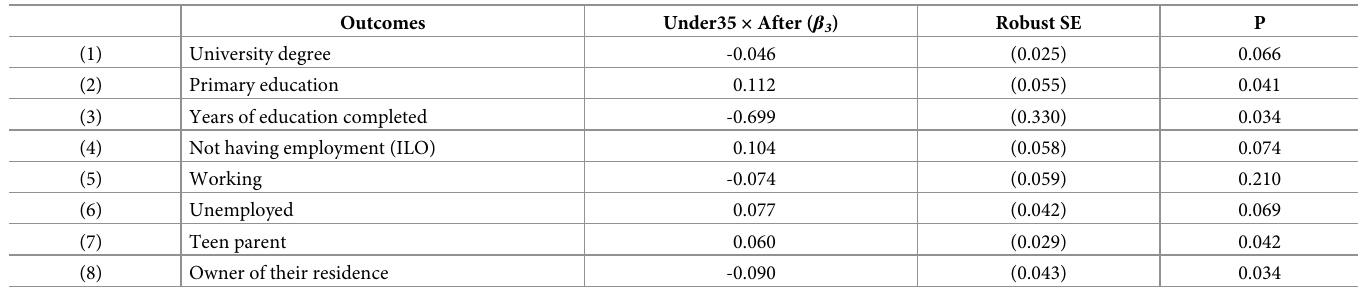
Table 1. The effect of abortion restrictions on socioeconomic outcomes in